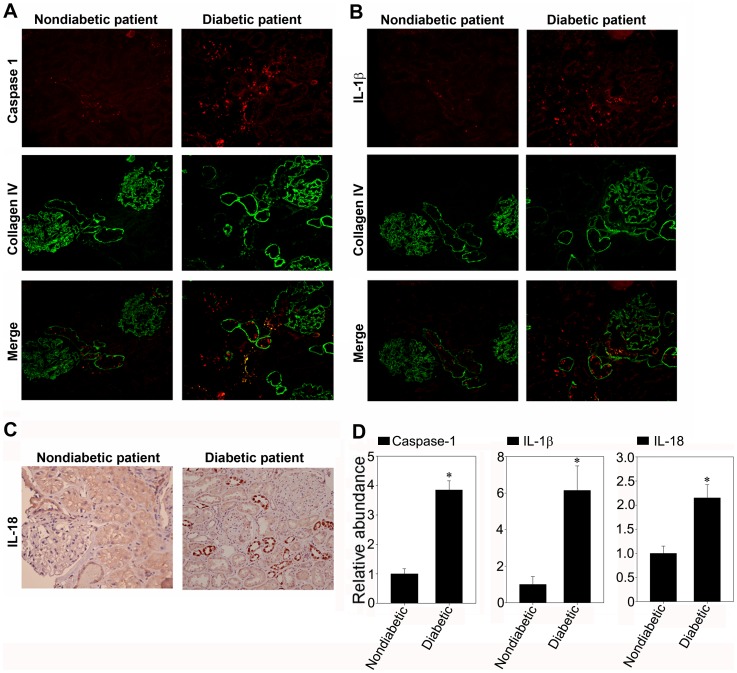
The inflammasome markers were activated in the renal tubular epithelia of diabetic nephropathy in the renal biopsies.A. Representative micrographs by immunofluorescence staining of caspase-1 (red) and collagen IV (green) in nondiabetic patients and diabetic patients, demonstrating the predominance of tubular staining for active caspase-1 in diabetic renal biopsies. B. Representative micrographs by immunofluorescence staining of IL-1β (red) and collagen IV (green). C. Representative micrographs by immunohistochemical staining of IL-18. D. The histogram demonstrated the relative abundance of the semiquantitative histomorphometric analysis of the immunostaining of caspase-1, IL-1β, and IL-18 (n = 5). *P<0.05 vs. the patients with mild mesangium proliferative glomerulonephritis.